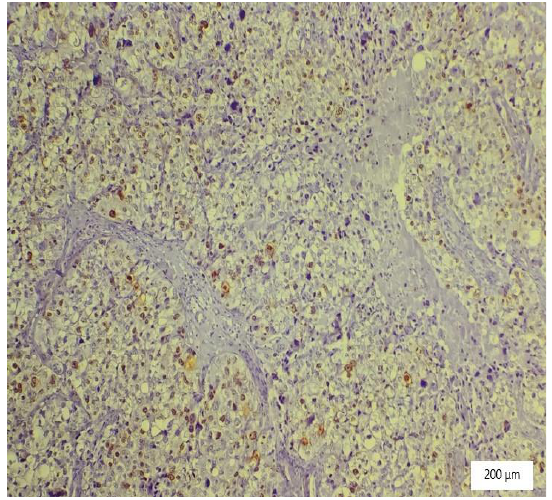
Figure 8. Ki 67 positivity in tumor cells (×100).